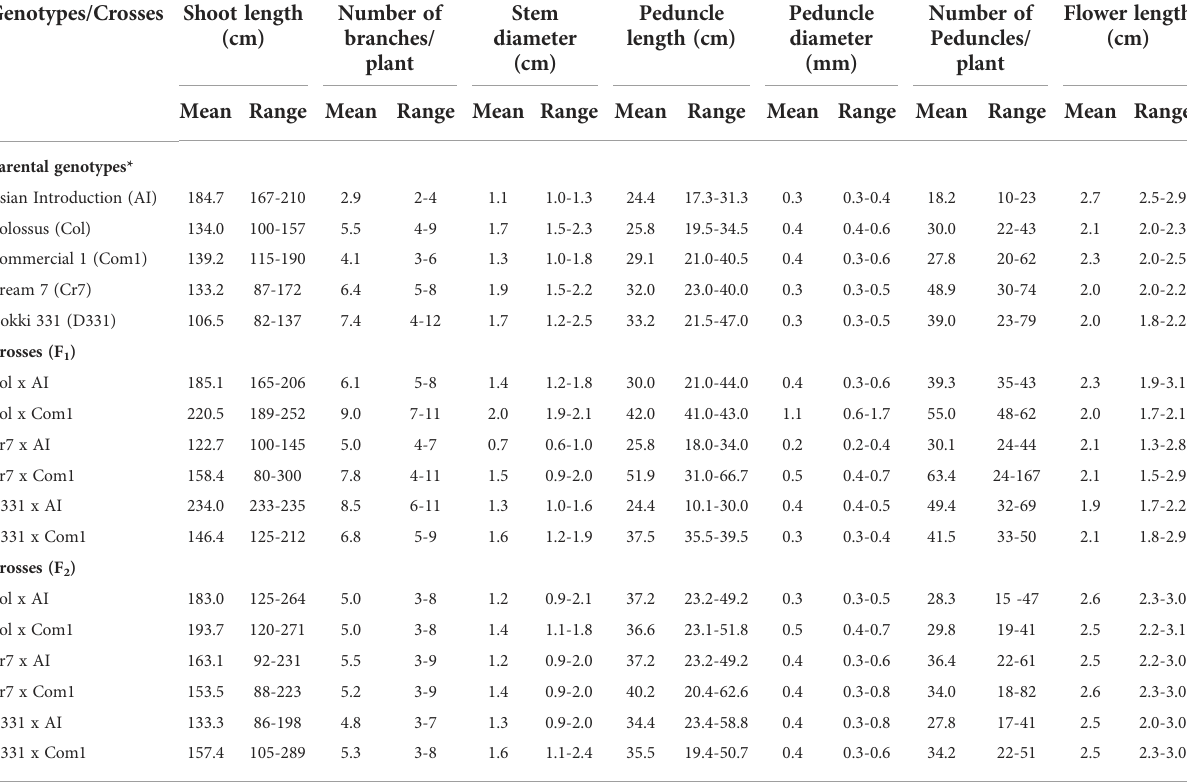
TABLE 2 Mean and range of shoot length (cm), number of branches, stem diameter (cm), peduncle length (cm), peduncle diameter (mm), number of peduncles/plant, and fl ower length (cm) of six cowpea crosses produced from fi ve different genotypes in F 1 , F 2 generations. Genotypes/Crosses Shoot